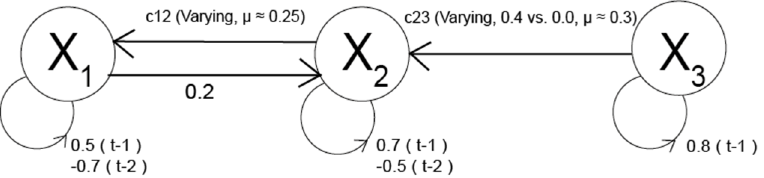
Figure 2. Ground Truth 1 with three fixed dipoles.